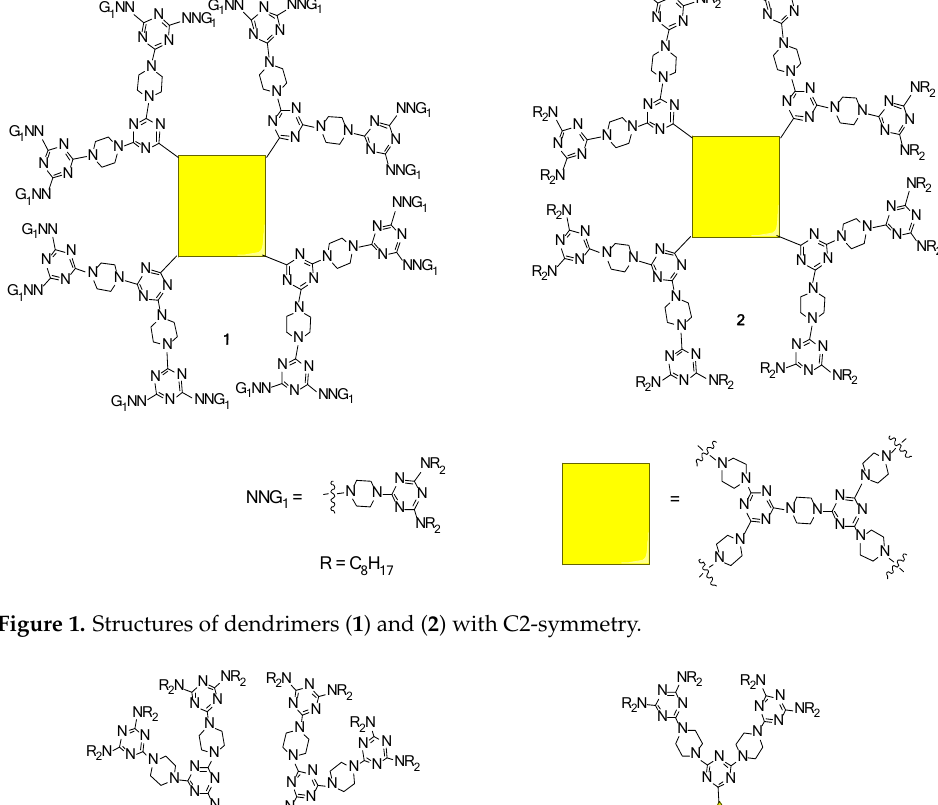
Figure 1. Structures of dendrimers ( 1 ) and ( 2 ) with C 2 -symmetry.